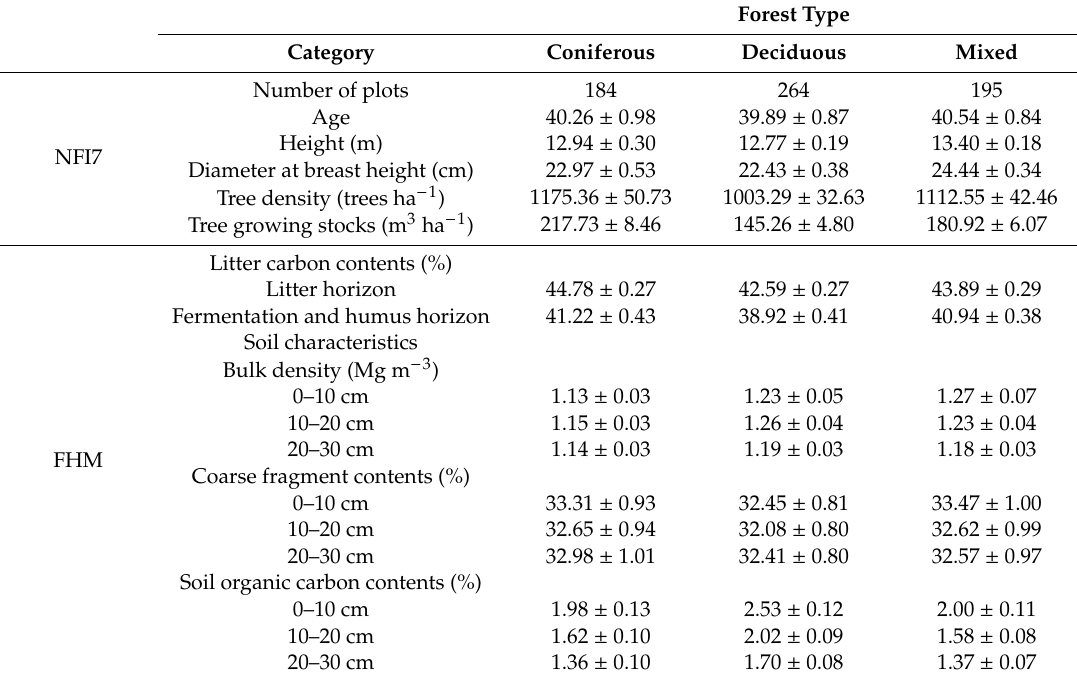
Figure 2. Plot design of National Forest Inventory (NFI) and Forest Health Monitoring (FHM) survey in South Korea. Table 1. Mean ± standard error in the seventh National Forest Inventory (NFI7) and Forest Health Monitoring (FHM) survey